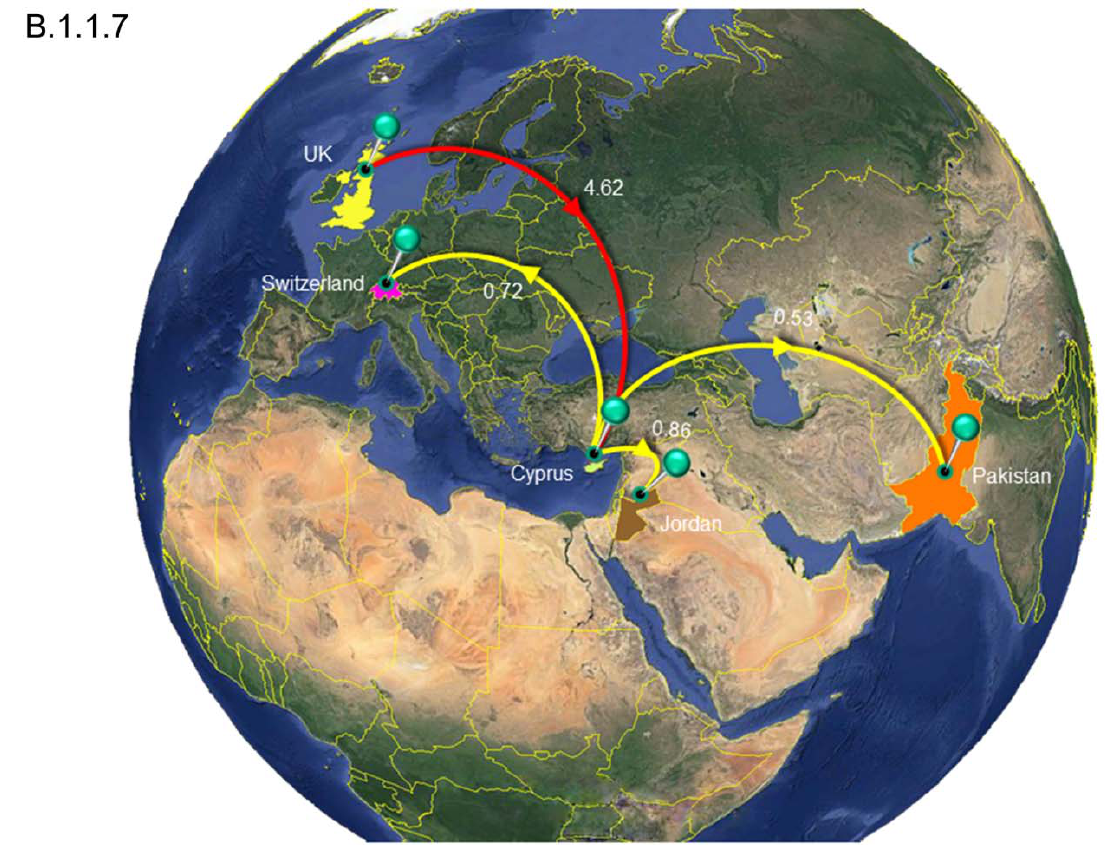
Figure 10. Map of SARS-CoV-2 B.1.1.7 clade group transmission between Cyprus and other countries. The geographic origins SARS-CoV-2 B.basal infection imported into Cyprus based on the statistical phylogeographic analysis are shown as red lines, and exports from Cyprus to other countries are shown as yellow lines. Countries and continents acting as “sources” or “sinks” for SARS-CoV-2 B.1.1.7 transmission are highlighted and labeled, and the average number of migration events is indicated. Map images courtesy of Google Earth Pro 7.3.2.5776 (14 December 2015). Global view centered on Europe. 36°16 ′ 38.78 ″ N 36°07 ′ 29.71 ″ E, Eye alt 7949.12 km. US Dept. of State Geographer, DATA SIO, NOAA, U.S. Navy, NGA, GEBCO. Image Landsat/Copernicus. 2018 © Google. https://www.google.com/earth/versions/#earth-pro (accessed on 10 April 2019).